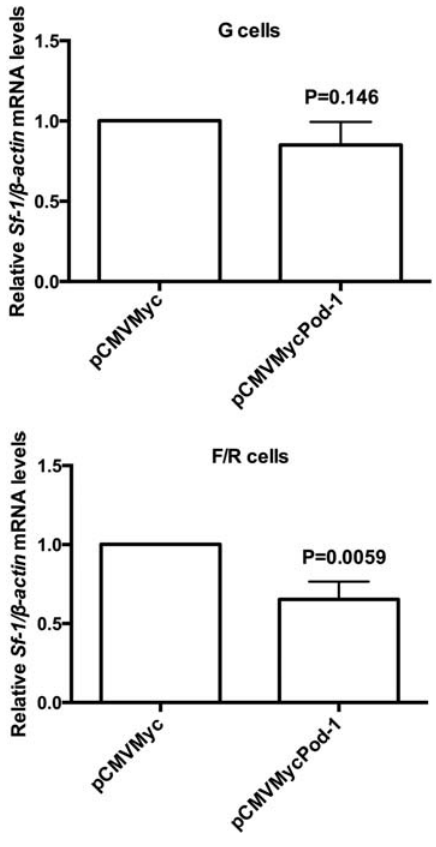
Figure 4. Quantitative reverse transcription PCR (qRT-PCR) analysis of relative Sf-1/ b -actin mRNA levels in primary rat adrenal glomerulosa cells (G cells) and fasciculata/reticularis cells (F/R cells) that had been transiently transfected with the empty vector pCMVMyc or with pCMVMycPod-1. Total RNA samples used in qRT-PCR were prepared 48 h post-transfection. Data are reported as the means ± SD of three experiments. Statistical signi fi cance was assessed by paired t